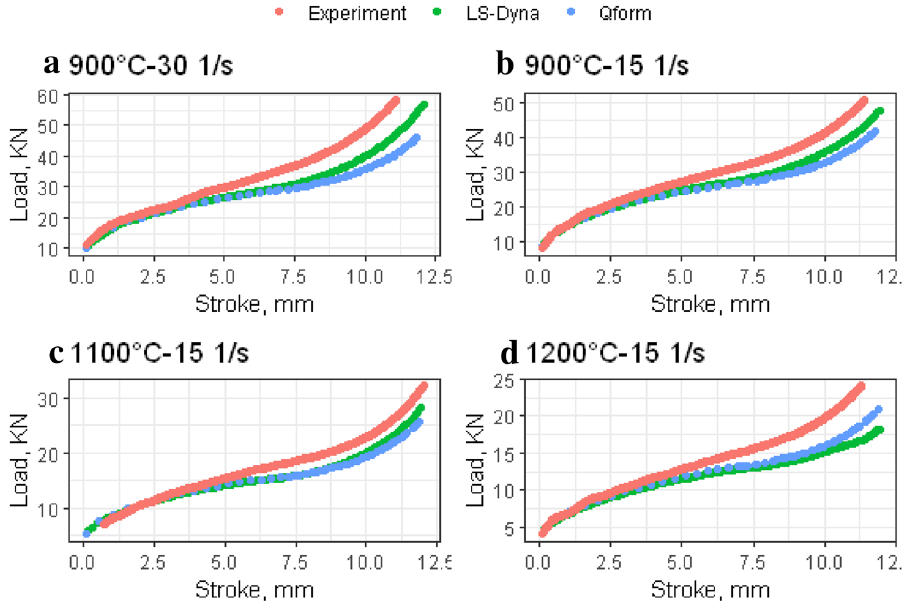
Fig. 5 Load vs. stroke results for selected